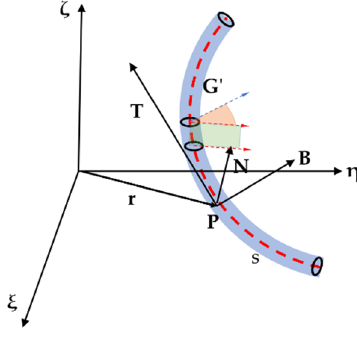
Figure 2. Coordinate systems of the flexible